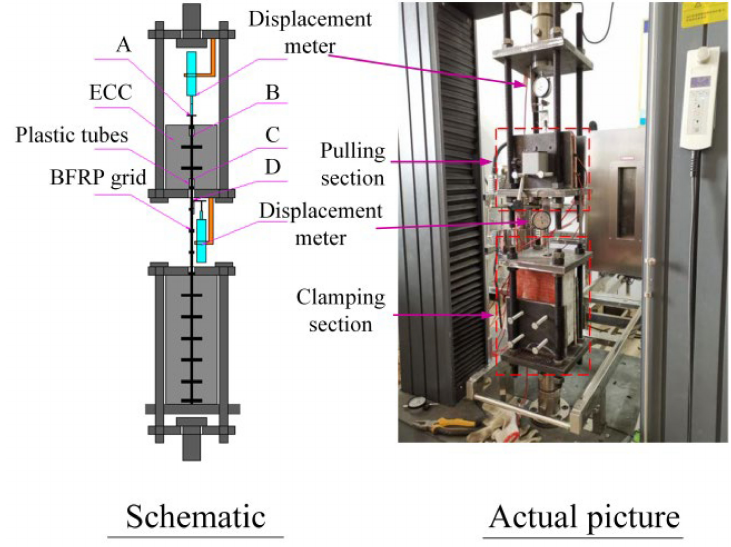
Figure 2. Drawing test device